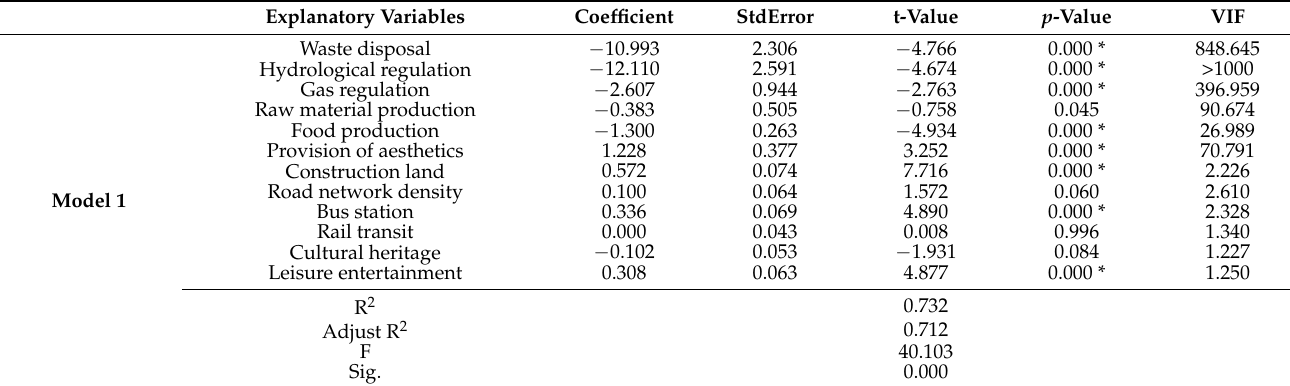
Table 3. Results of the linear regression analysis. * p <